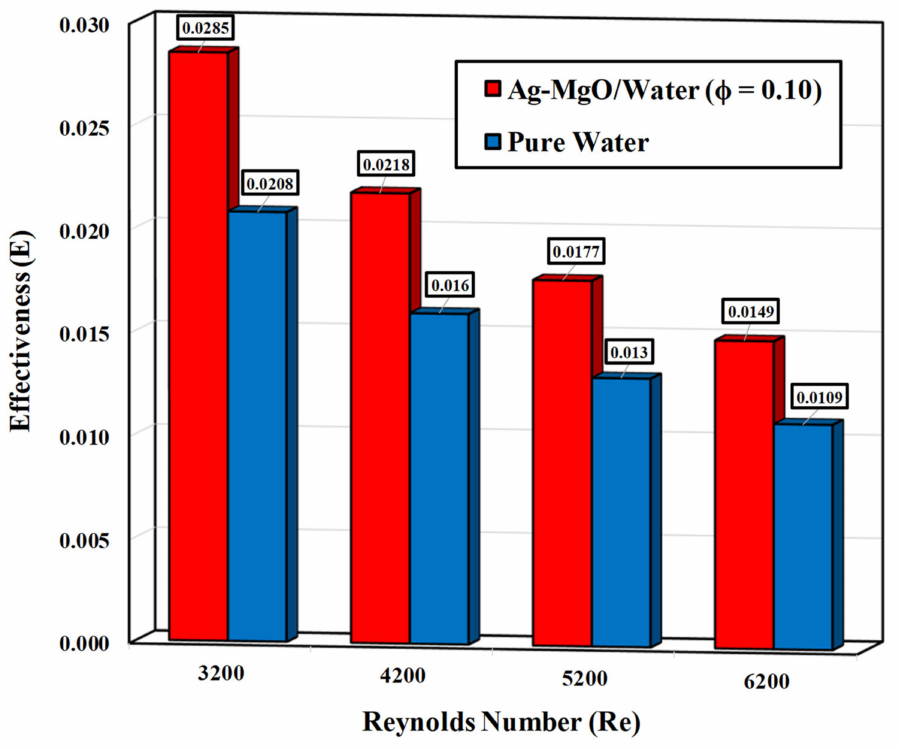
Figure 17. Effectiveness when using Ag-MgO/water hybrid nanofluid with different Reynolds numbers at φ = 0.10.